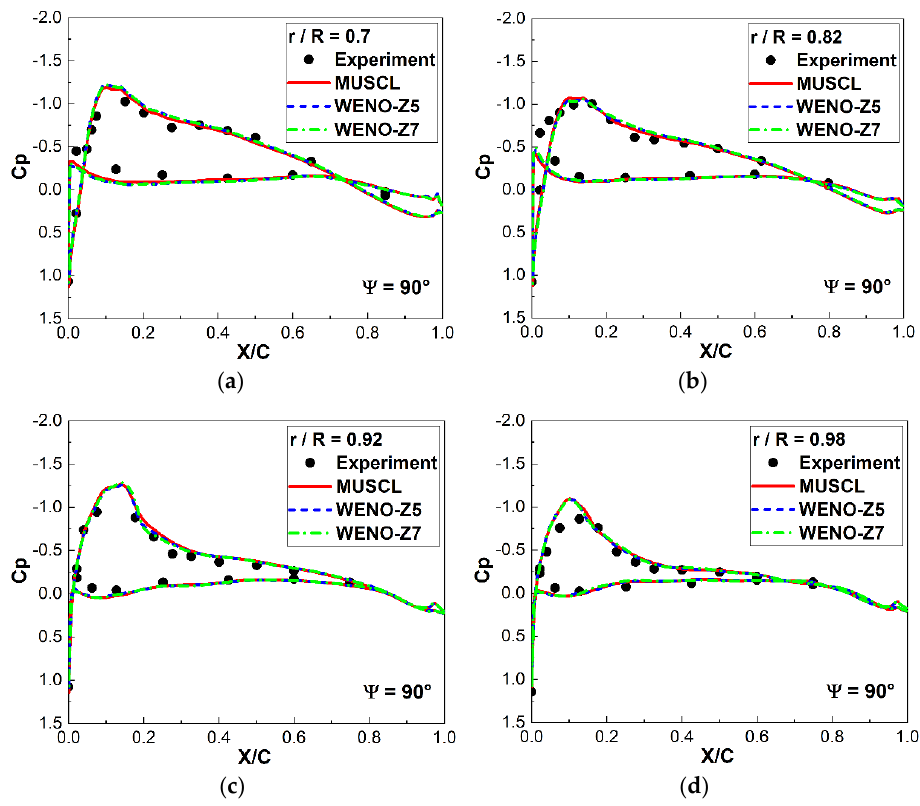
Figure 5. The pressure coefficients of the Helishape-7A rotor blade section for the WENO-Z and MUSCL schemes: ( a )   90° (r/R = 0.7); ( b )   90° (r/R = 0.82); ( c )   90° (r/R = 0.92); ( d )  the MUSCL schemes: ( a ) ψ = 90 ◦ (r/R = 0.7); ( b ) ψ = 90 ◦ (r/R = 0.82); ( c ) ψ = 90 ◦ (r/R = 0.92);  90° (r/R = 0.98). ( d ) ψ = 90 ◦ (r/R =